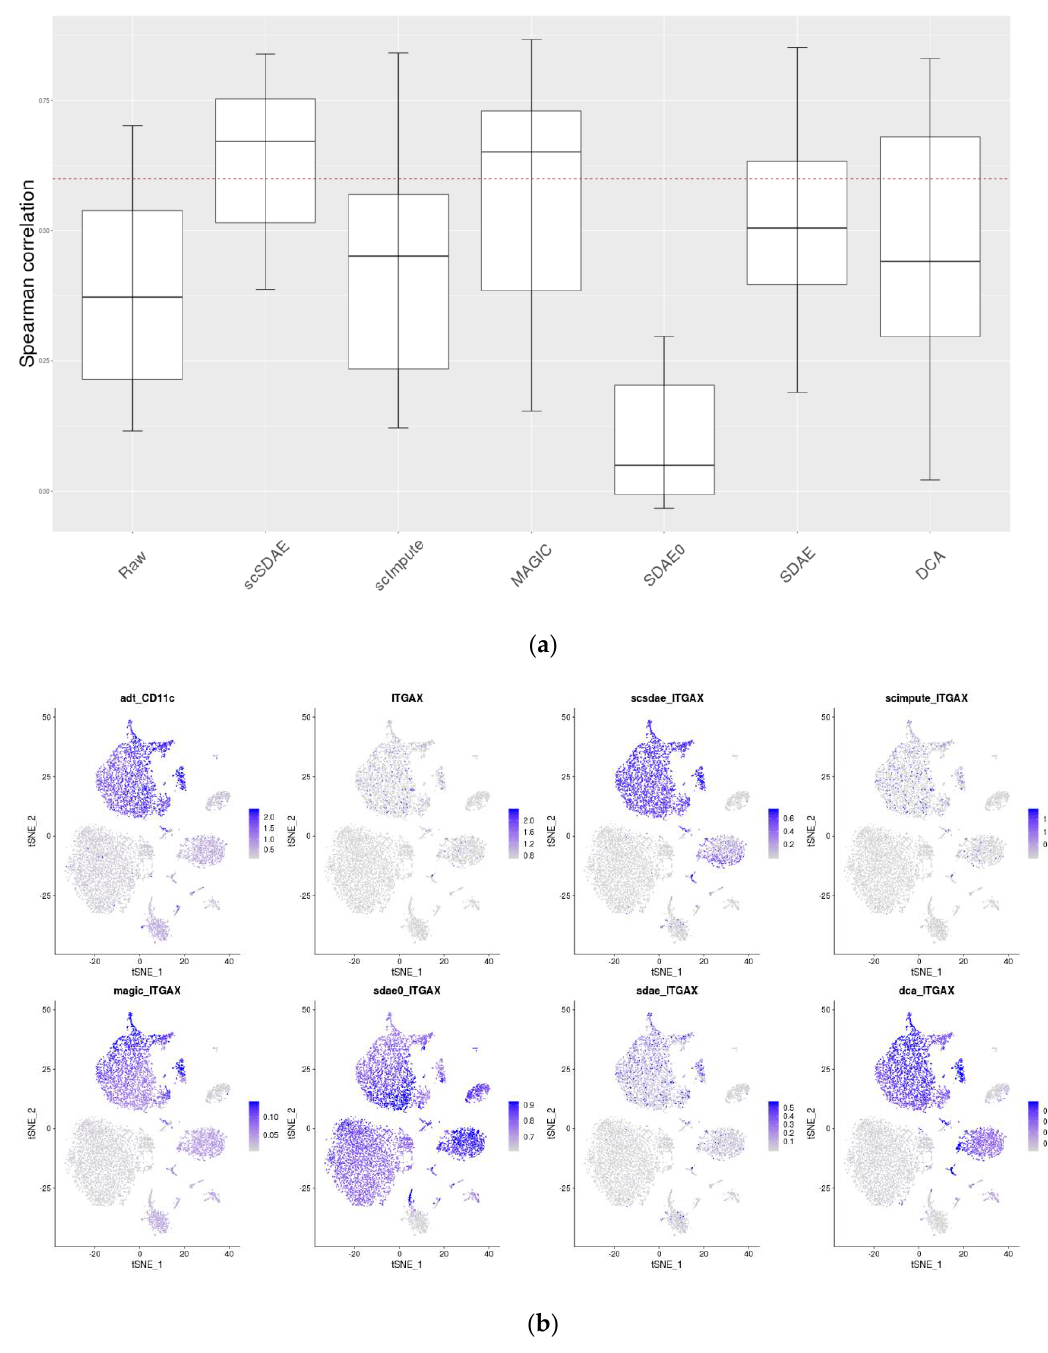
Figure 5. Consistency of RNA and protein levels in CITE-seq data. ( a ) Boxplot of the Spearman correlations of the protein-RNA pairs in CITE-seq data (The red dashed line represents y = 0.6). ( b ) Featureplot of the cells in CITE-seq data. TSNE visualizations of the cells are shown in the figure where each point represents a cell, and the colors of points indicate the expression levels of the protein and corresponding RNA of gene CD11c ( ITGAX ).